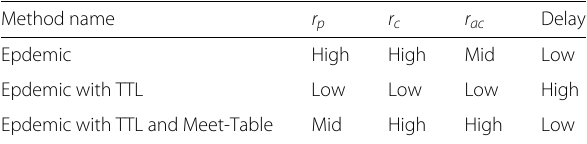
Table 2 Summary of performance simulation